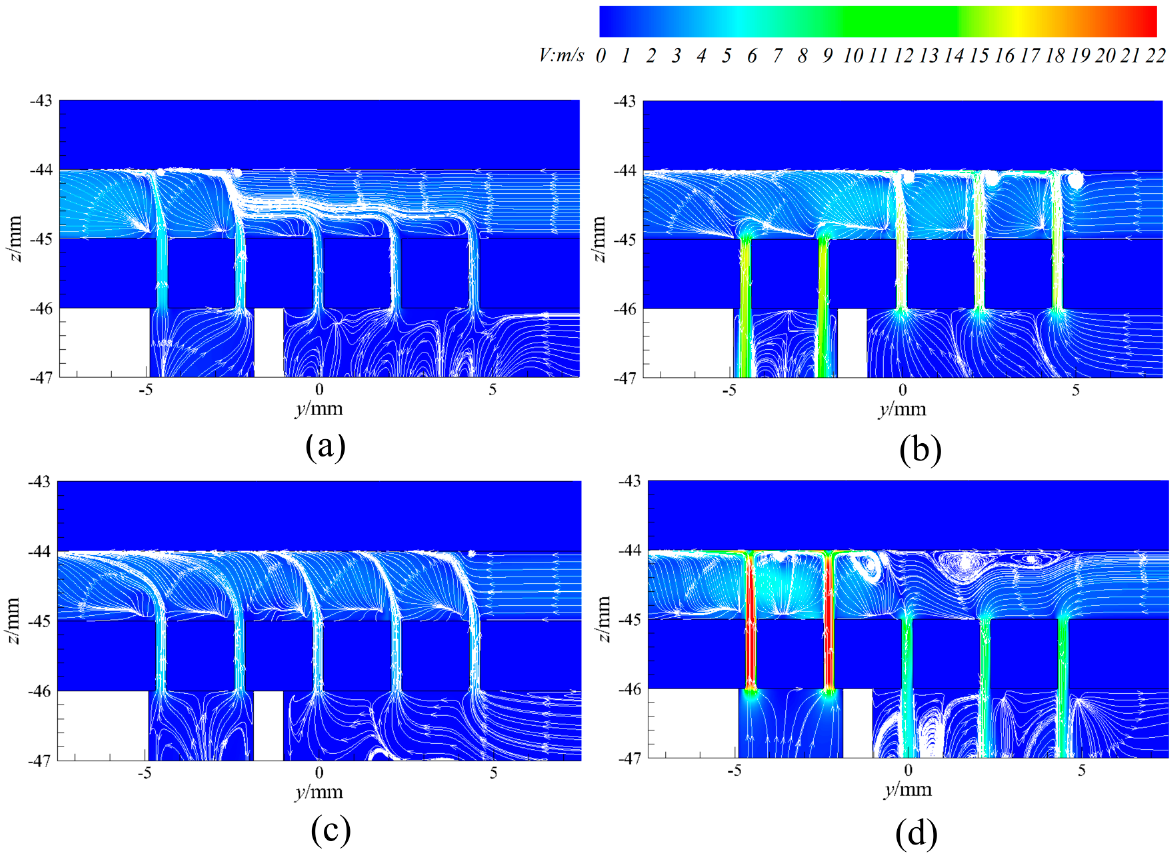
Figure 13. Velocity distribution of channel’s center section ( x = 28.5 mm, partial enlarged view of jet orifice area) (DSJ on): ( a ) 0 T (1 T); ( b ) 0.25 T; ( c ) 0.5 T; ( d ) 0.75 T.